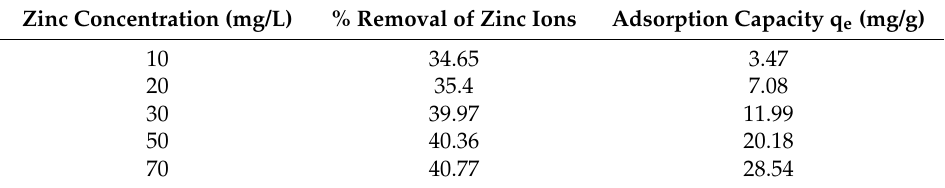
Table 1. The percentage of zinc ions removal and adsorption capacity of HAp upon varying the zinc